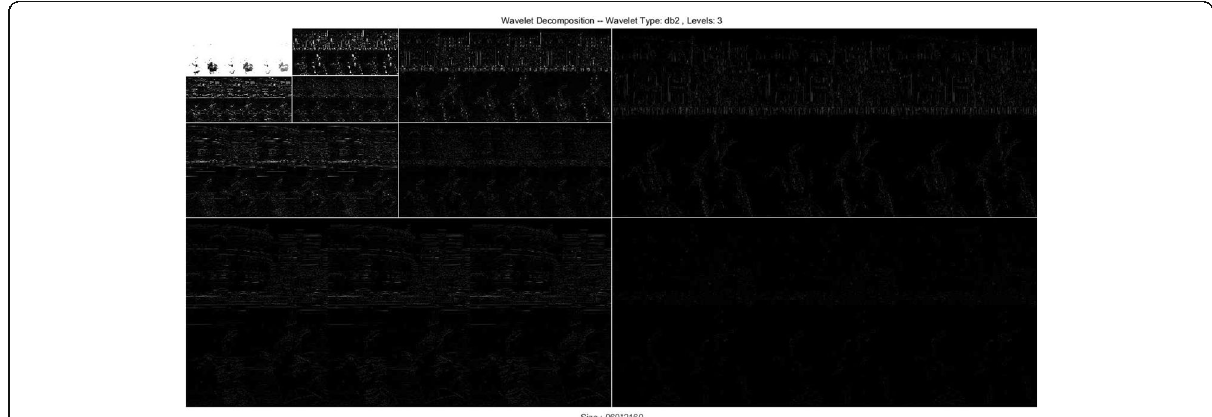
Fig. 3 Image information after three-layer wavelet